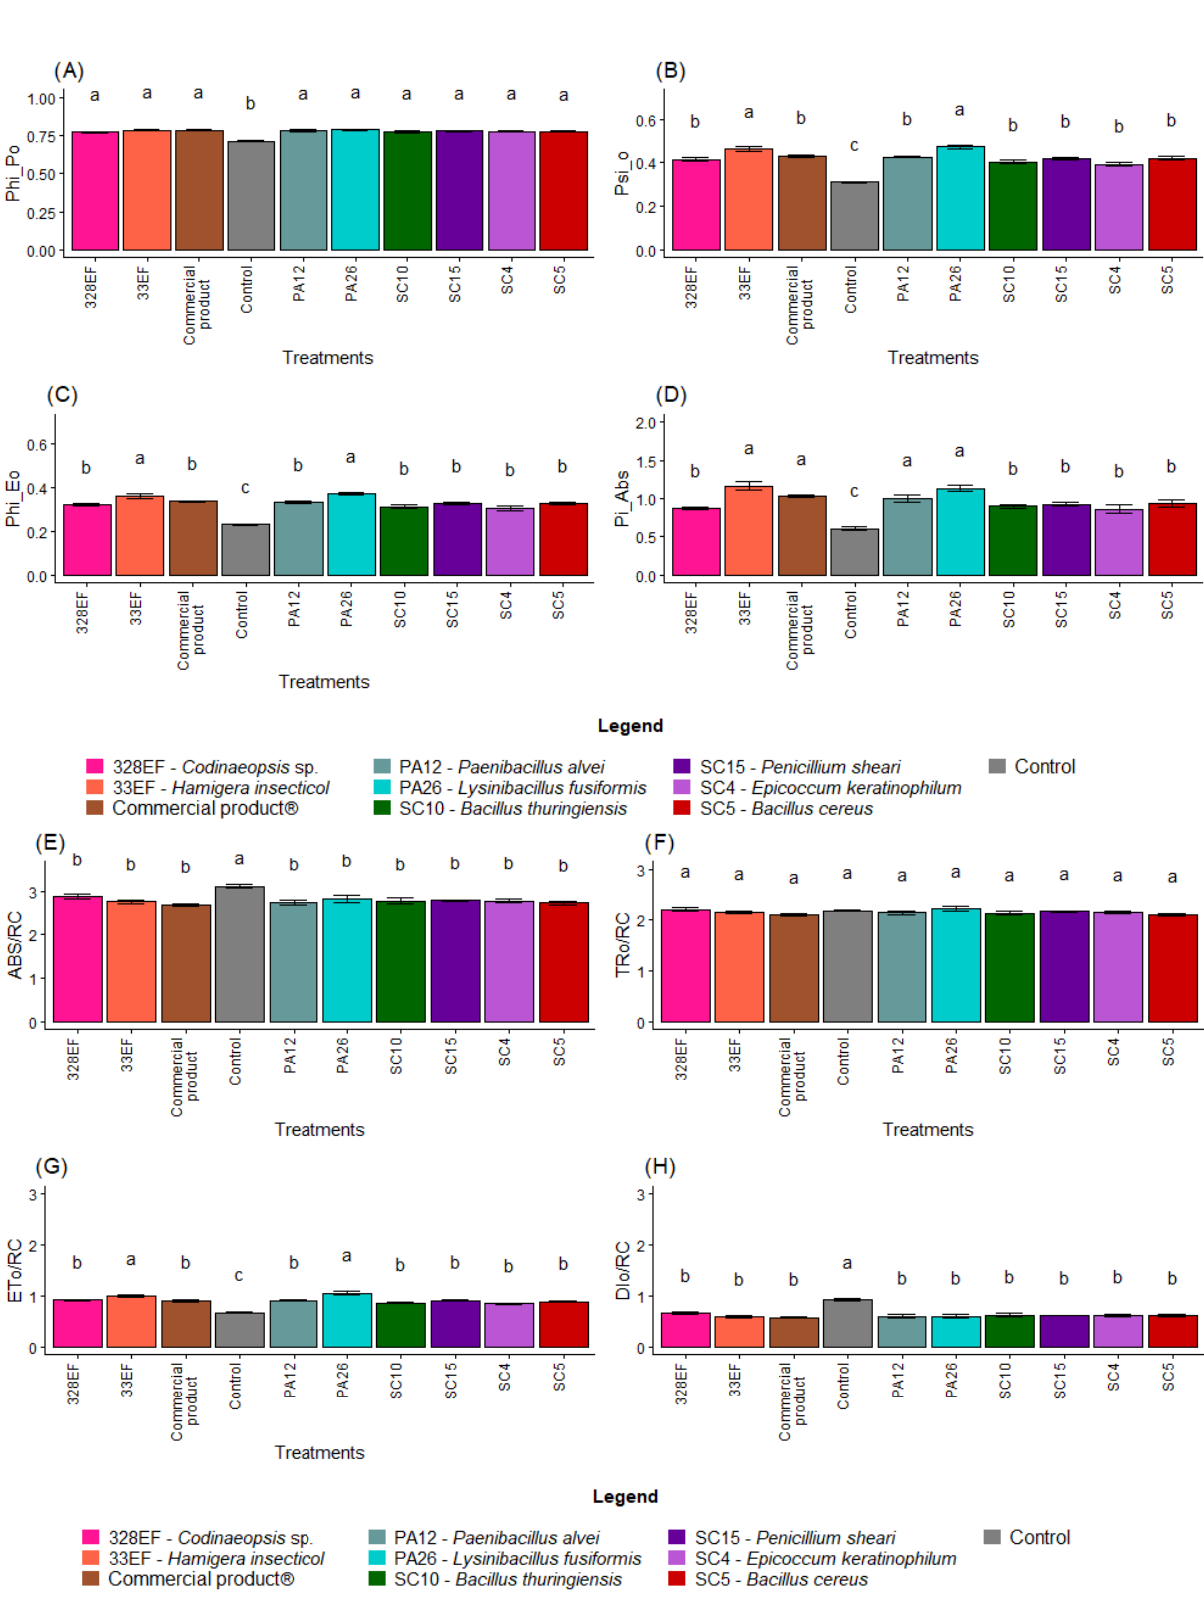
Figure 6. Maximum quantum yield of primary photochemistry (PHI_Po) ( A ), probability that a trapped exciton moves an electron into the electron transport chain beyond Quinone (Qa) (PSI_O) ( B ), quantum yield of electron transport (PHI_Eo) ( C ), photosynthetic performance index (Pi_Abs) ( D ), absorption flux per RC (ABS. RC) ( E ), energy flux per RC at t = 0 (TR0. RC) ( F ), electron transport flux per RC at t = 0 (ET0/RC) ( G ), and specific dissipated energy flux (DI0. RC) ( H ) in soybean ( Gly- cine max) plants inoculated with fungal and bacterial strains isolated from Hymenaea courbaril and Butia purpurascens and grown in a controlled greenhouse system. Means followed by the same letter were not significantly different using the Scott – Knott test at 0.05% probability.